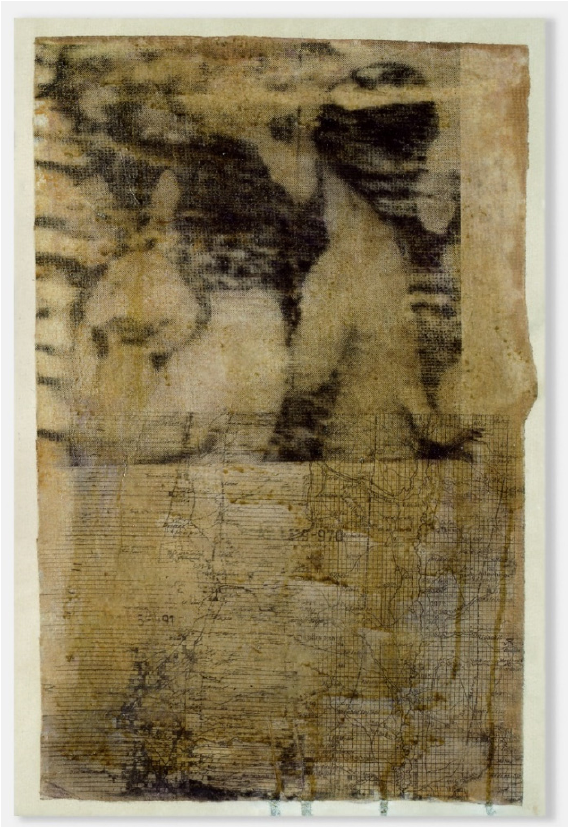
Figure 9. Bracha L. Ettinger, “Eurydice18”, 1992–1996, oil and mixed technique on paper mounted on canvas. (C) Courtesy of the artist.